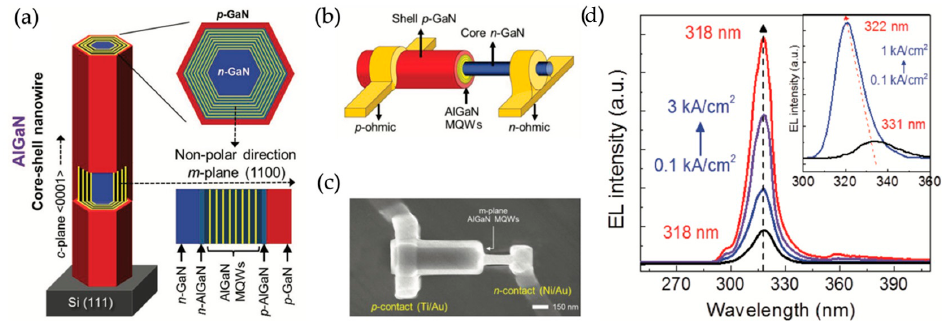
Figure 9. ( a ) Schematic of the structure of single AlGaN nanowire UV LEDs using lateral nonpolar quantum wells. ( b ) Schematic and ( c ) SEM image of the fabricated single AlGaN nanowire UV LED with lateral nonpolar quantum wells. ( d ) EL spectra under different injection currents. Inset: EL spectra of an axial nanowire UV LED for a comparison purpose (see the main text) [106] .